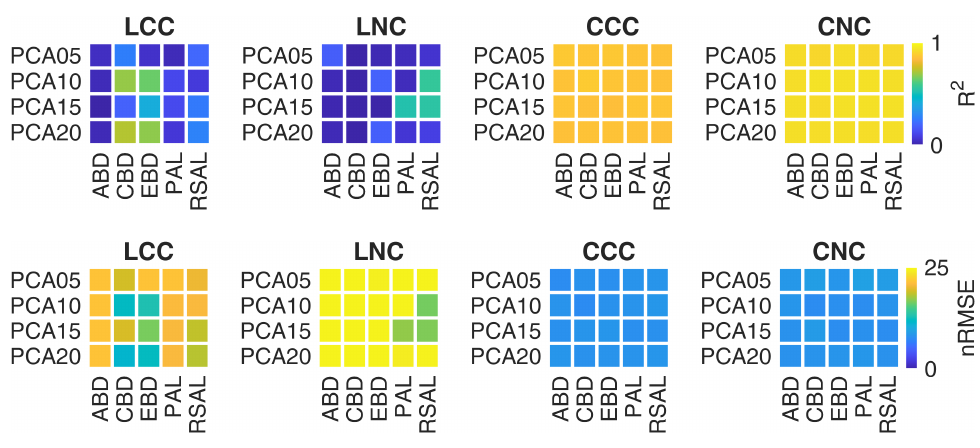
Figure 3. Metrics of crop traits estimation through HAL for different combinations of AL heuristics and spectral DR configurations, in terms of R 2 and nRMSE.